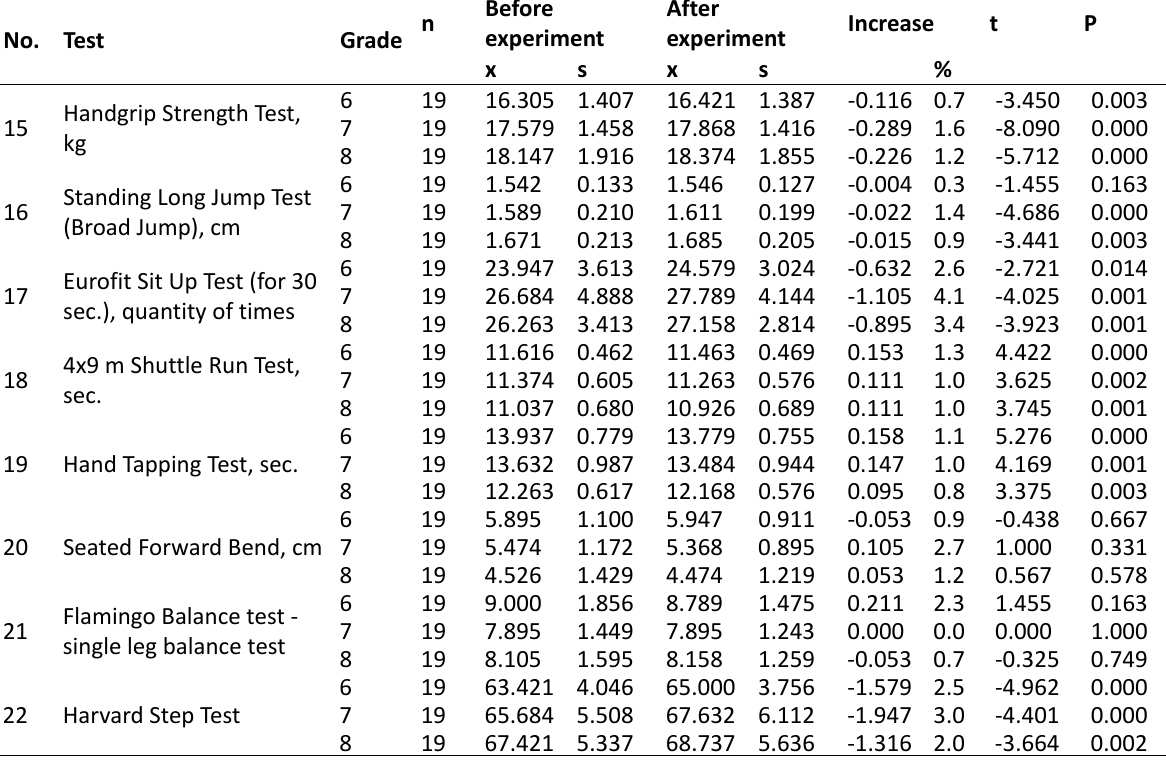
Table 4. Test results of strength fitness of 6 th -8 th grade boys after a one-month physical training cycle using the combined method of strength development and the circuit training method (experimental group).